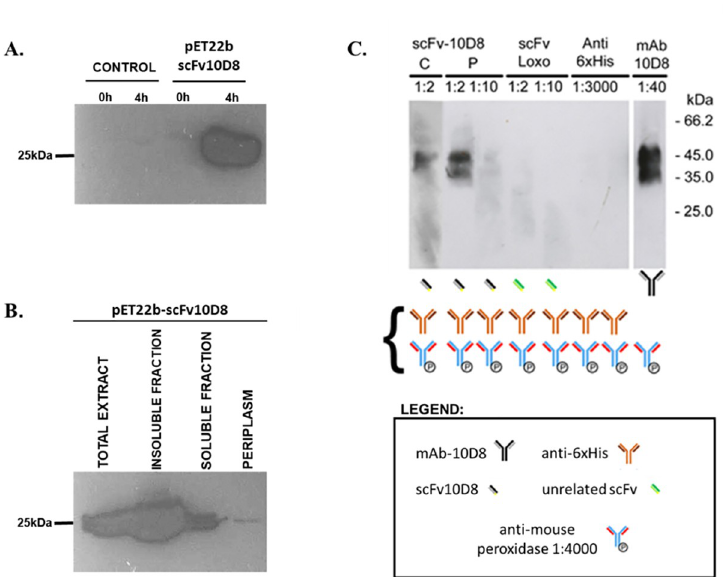
Fig 3. Expression, solubility and reactivity of scFv-10D8. a Western blotting of extracts obtained from uninduced (0 h) or induced (4 h) cultures of Escherichia coli Rosetta strain without (control) or with pET22b-scFv-10D8. Samples from uninduced and induced cultures were harvested, normalized by absorbance at 600 nm (cells from 1.5 mL culture at 0.5 OD are resuspended in 100 μ L of sample buffer) and subjected to SDS-PAGE followed by Western blot using Anti-His antibody. b Bacterial cells were fractionated in periplasm, soluble cytoplasmic proteins and insoluble proteins and then tested for scFv-10D8 presence by Western blot using anti-6 × His antibody. Insoluble and soluble fractions were prepared keeping the ratio during lysis process of 20 mL culture, and the total extracts corresponds to the sample from previous Western blot (4h after induction). Panel c shows immunoblots of epimastigote cell extracts (2 × 10 6 parasites/lane) probed with scFvs or mAbs as primary antibodies and their controls. The scheme below the blots shows the sequence of antibody incubation used to detect their reactivity. Curly bracket corresponds to the antibodies used during Western blot detection step. “C” corresponds to soluble fraction of bacteria without periplasm, and “P” corresponds to a fraction containing soluble proteins located in the periplasm. Anti-6 × His and an unrelated scFv (scFv Loxo) were used as negative controls and mAb-10D8 as a positive